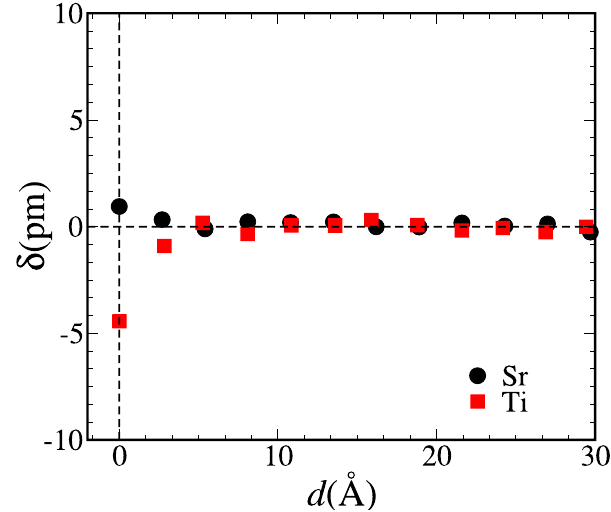
Figure 3. The variation of the Sr–Sr and Ti–Ti nearest-neighbor distances in the bulk and near the twin wall against the distance perpendicular to the wall [18].